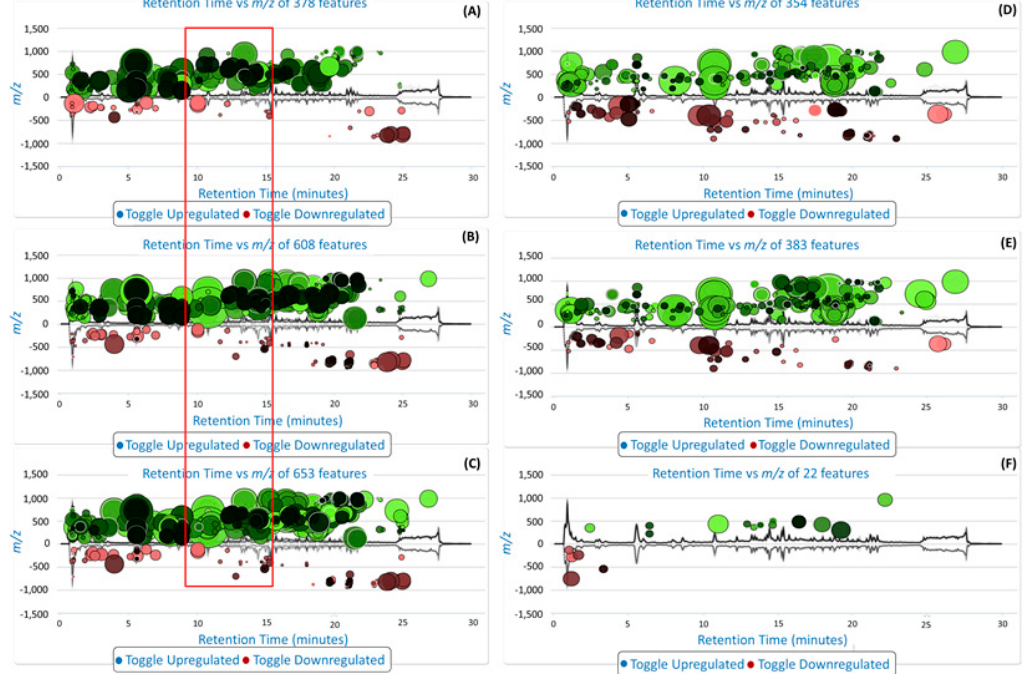
Figure 5. Liquid/gas chromatography mass spectrometry (XCMS) cloud plot of UHPLC-MS data: ( A ) ion comparisons between 50 ◦ C and 100 ◦ C; ( B ) ion comparisons between 50 ◦ C and 150 ◦ C; ( C ) ion comparisons between 50 ◦ C and 200 ◦ C; ( D ) ion comparisons between 100 ◦ C and 150 ◦ C; ( E ) ion comparisons between 100 and 200 ◦ C; and ( F ) ion comparisons between 150 ◦ C and 200 ◦ C. The ions that are enhanced due to an increase in temperature (100 ◦ C, 150 ◦ C and 200 ◦ C) are shown in the top plots (in green) and the ions that were extracted at a low temperature are shown in the bottom plot (in red).